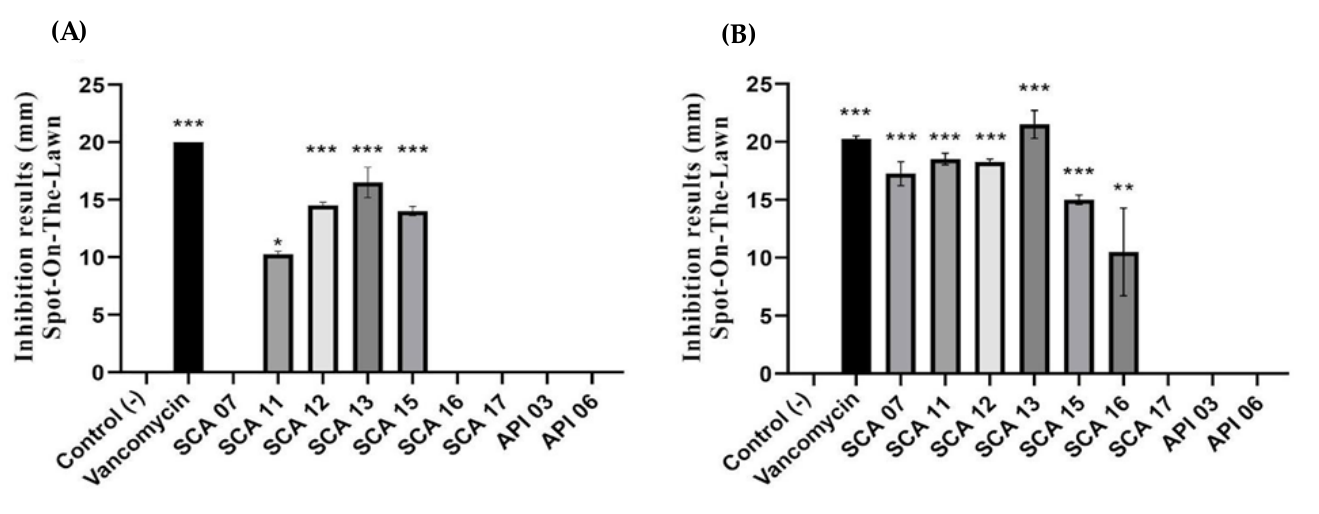
Figure 3. Antimicrobial activity of strains isolated from different kinds of honey against ( A ) L. monocytogenes , and ( B ) B. cereus . * p < 0.05; ** p < 0.01; *** p < 0.00001.